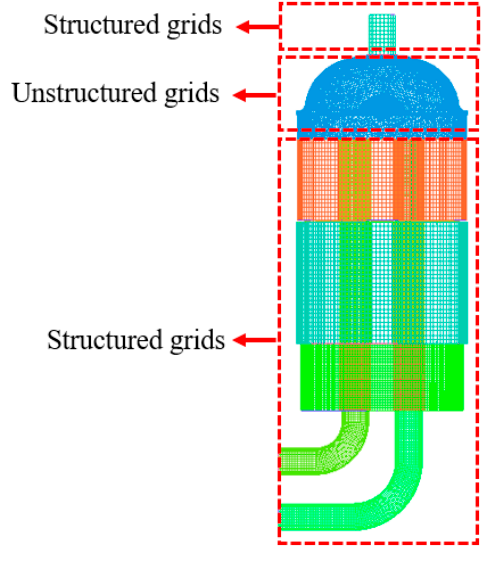
Figure 3. Computational grid.